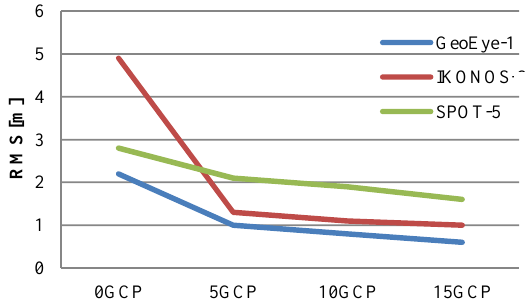
Figure 3. Root mean square differences at independent check points based on orientation with manually measured GCPs for different test areas